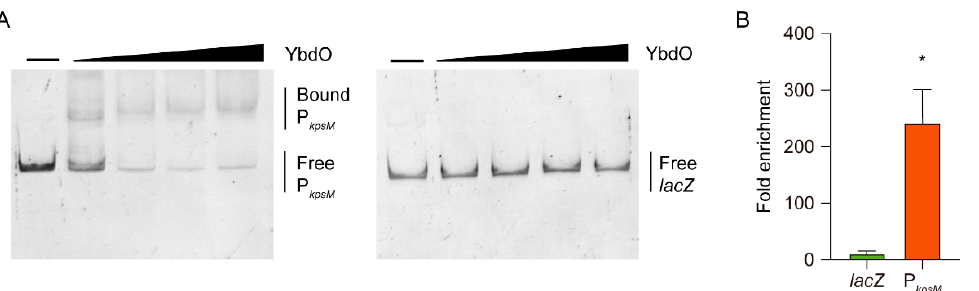
Figure 5. YbdO directly activates kpsM expression. ( A ) EMSA of the specific binding of YbdO to P kpsM and lacZ (negative control). PCR products were added to the binding buffer at 20 ng each, and YbdO protein was added to the reaction buffer (lanes 1–5) at 0, 0.15, 0.3, 0.6, and 1.2 μ M. ( B ) Fold enrichment of P kpsM and lacZ in YbdO-ChIP samples. The fold enrichment of the YbdO-binding sites was measured based on the percent input of IP as compared with that of MOCK. Data were obtained from three independent experiments and analyzed using Student’s t -test. * p < 0.05.